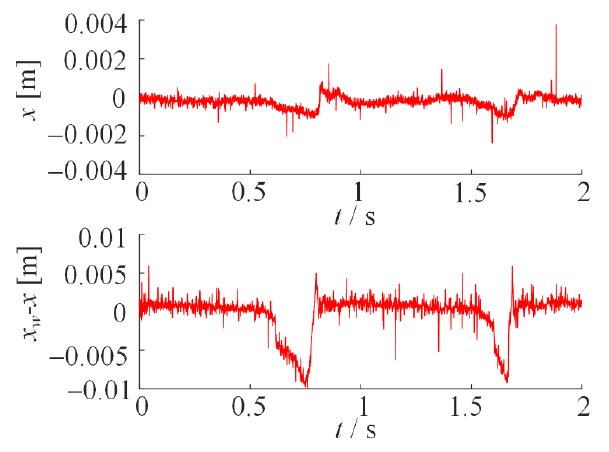
Figure 9. Test results of ADRC control.